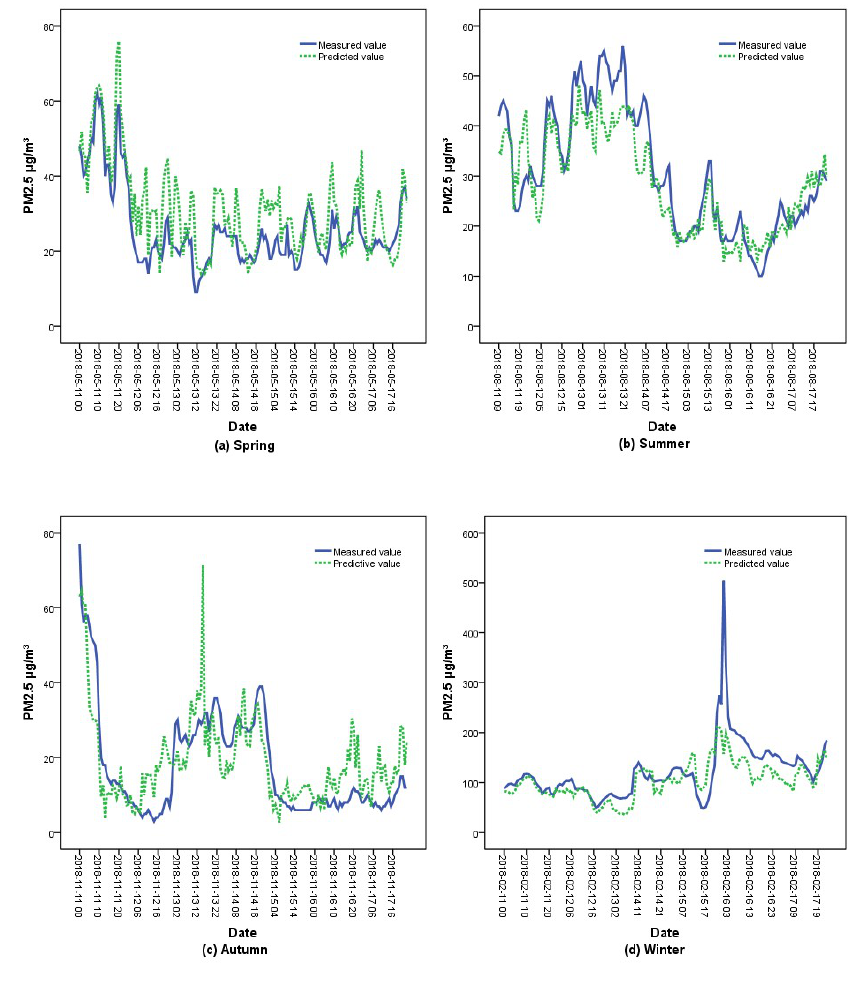
Fig.3 Comparison of measured and predicted values, based on BP